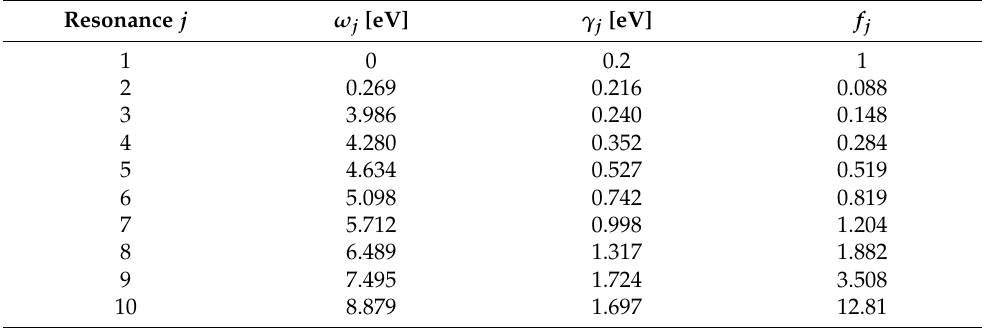
Table 2. The optical parameters of Drude–Lorentz model for AZO2 obtained from DFT-GGA calcula- tions [47].